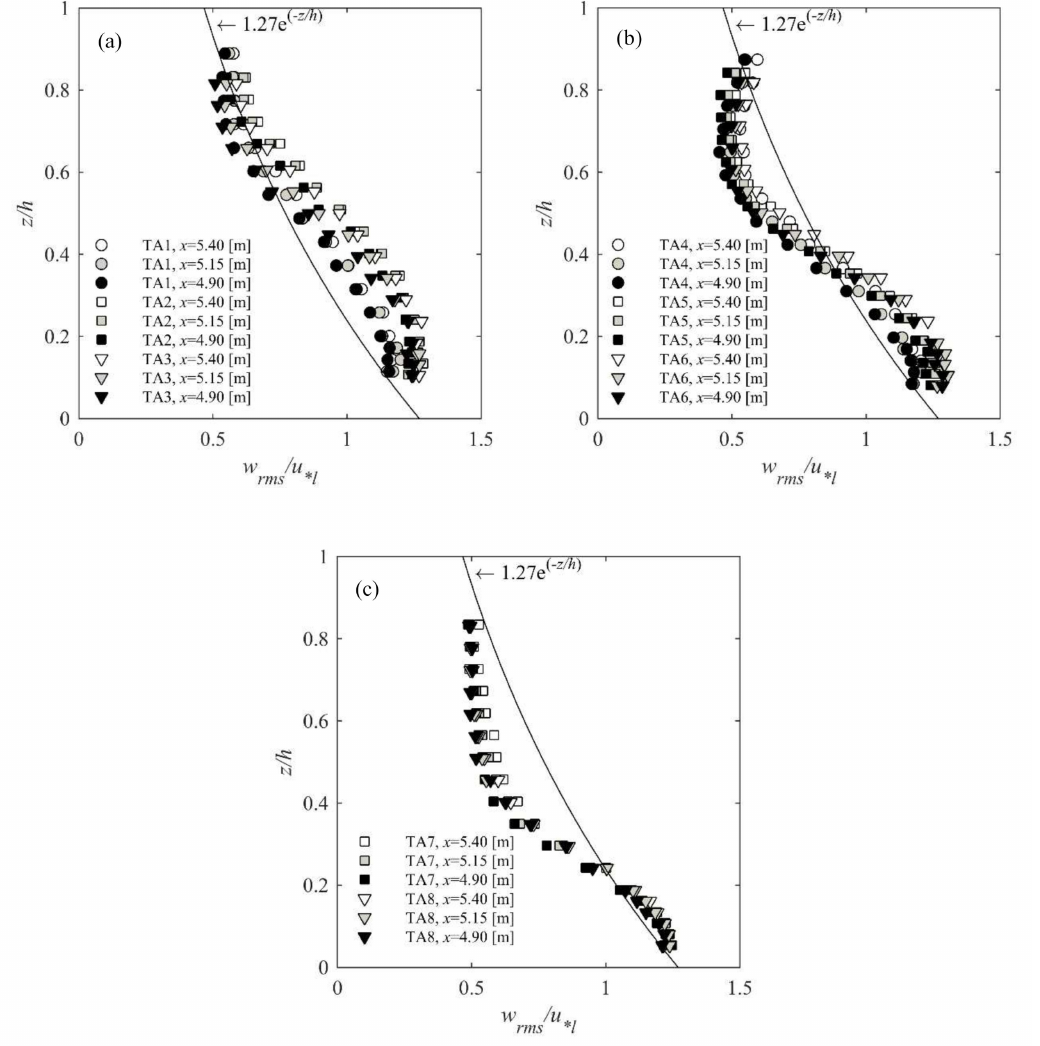
Figure 10. Normalized vertical turbulence intensity profiles for ( a ) TA1–TA3, ( b ) TA4–TA6, ( c ) TA7–TA8 in all cross-sections and universal fit